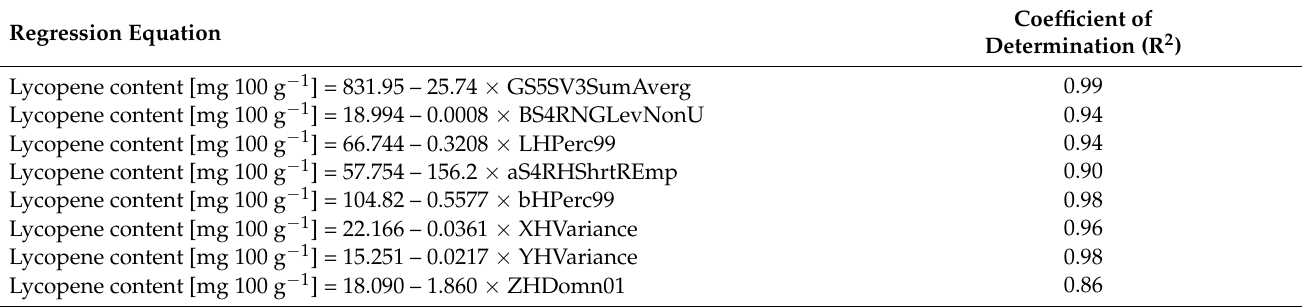
Table 5. The regression equations between lycopene content and selected image textures of ‘O˙zarowski’, ‘Marvel Striped’, ‘Green Zebra’, Sandoline F1, Cupidissimo F1, and Sacher F1